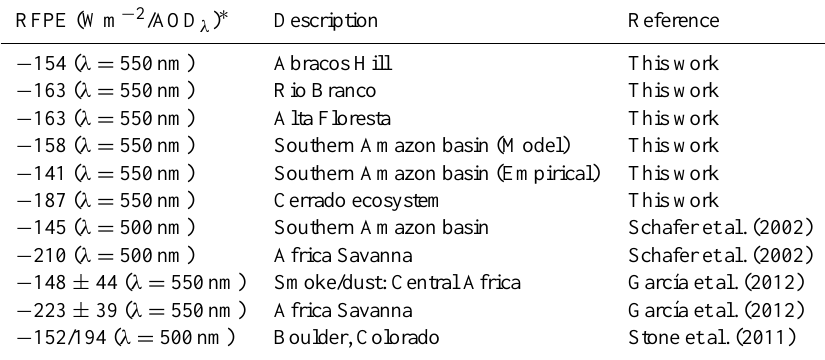
Table 4. Estimative of smoke aerosol Radiative Flux Perturbation Efficiency (RFPE) obtained in the present study and several estimates from previously published studies.